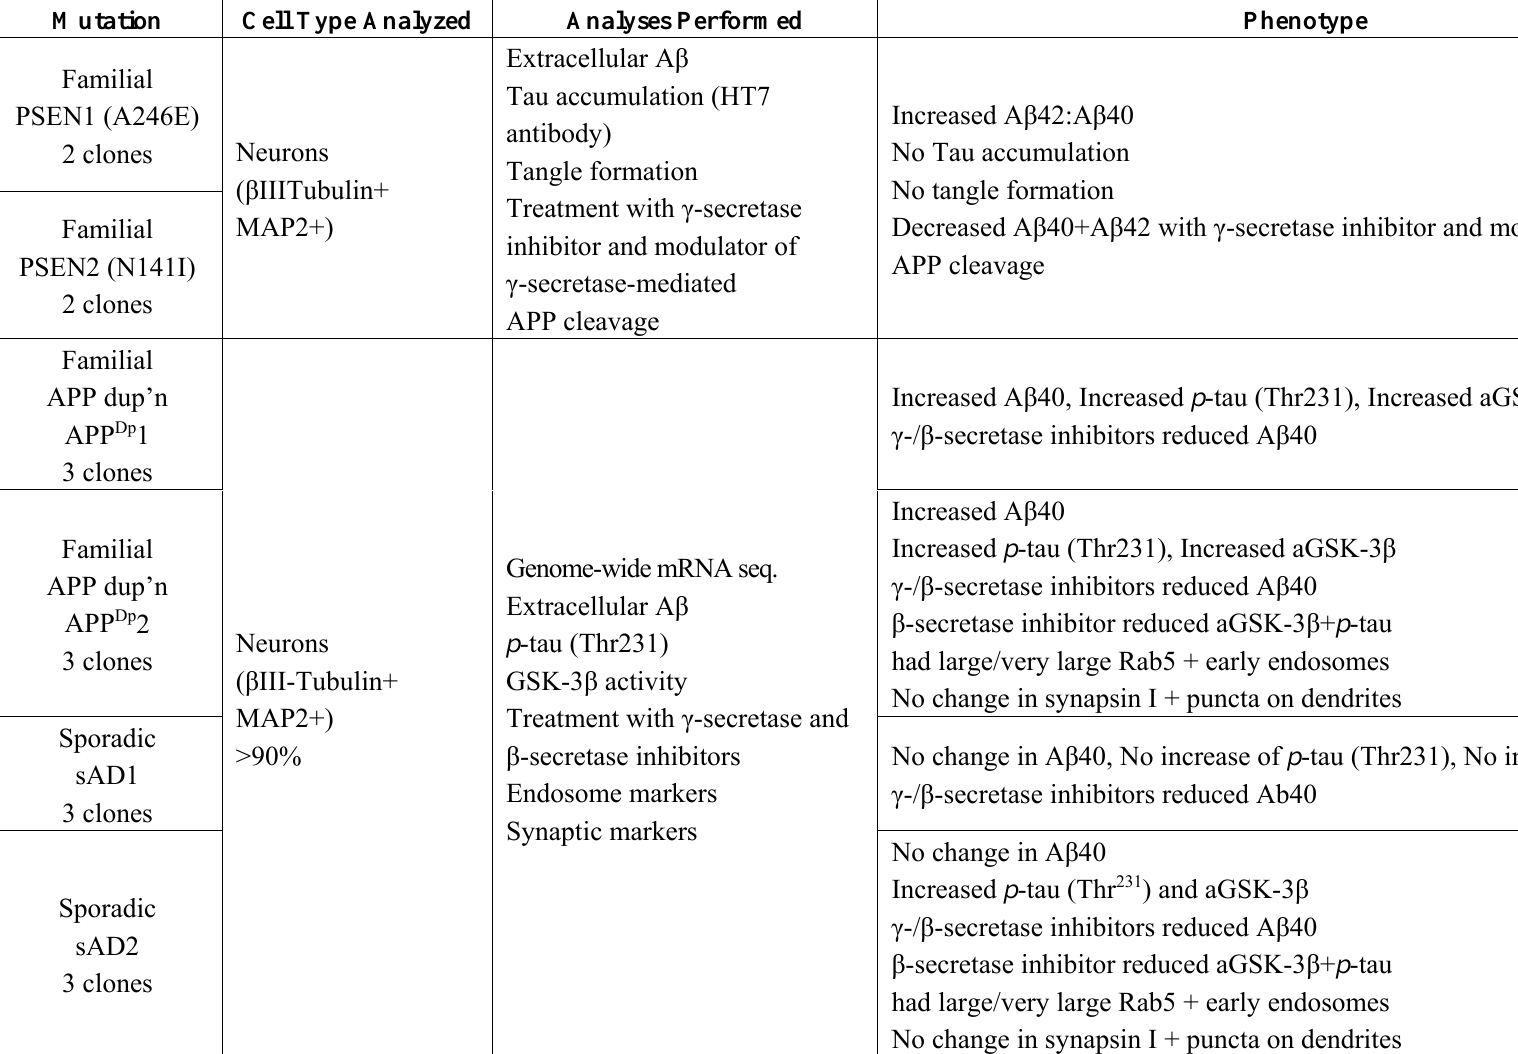
Table 1. Phenotypes of neural cells analyzed from differentiated patient-specific induced pluripotent stem cells for studying Alzheimer’s disease.